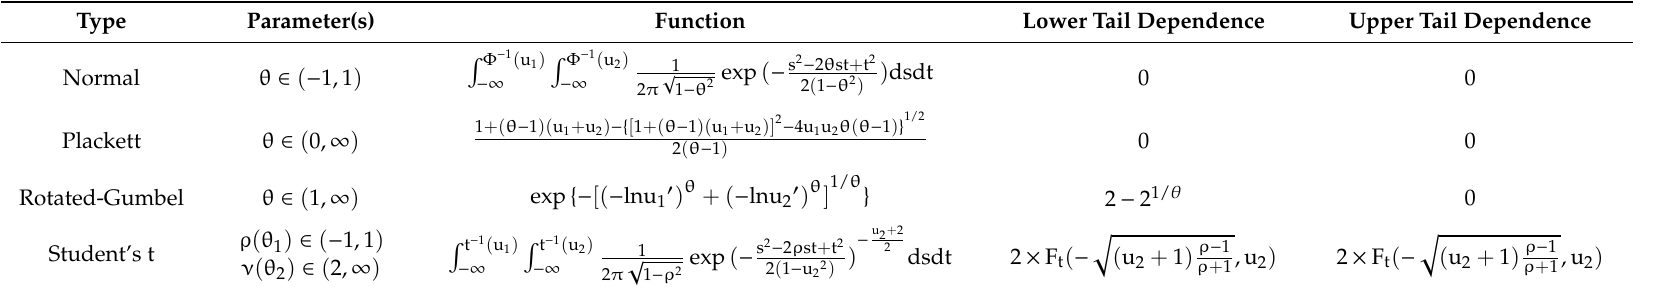
Table 2. Bivariate copula